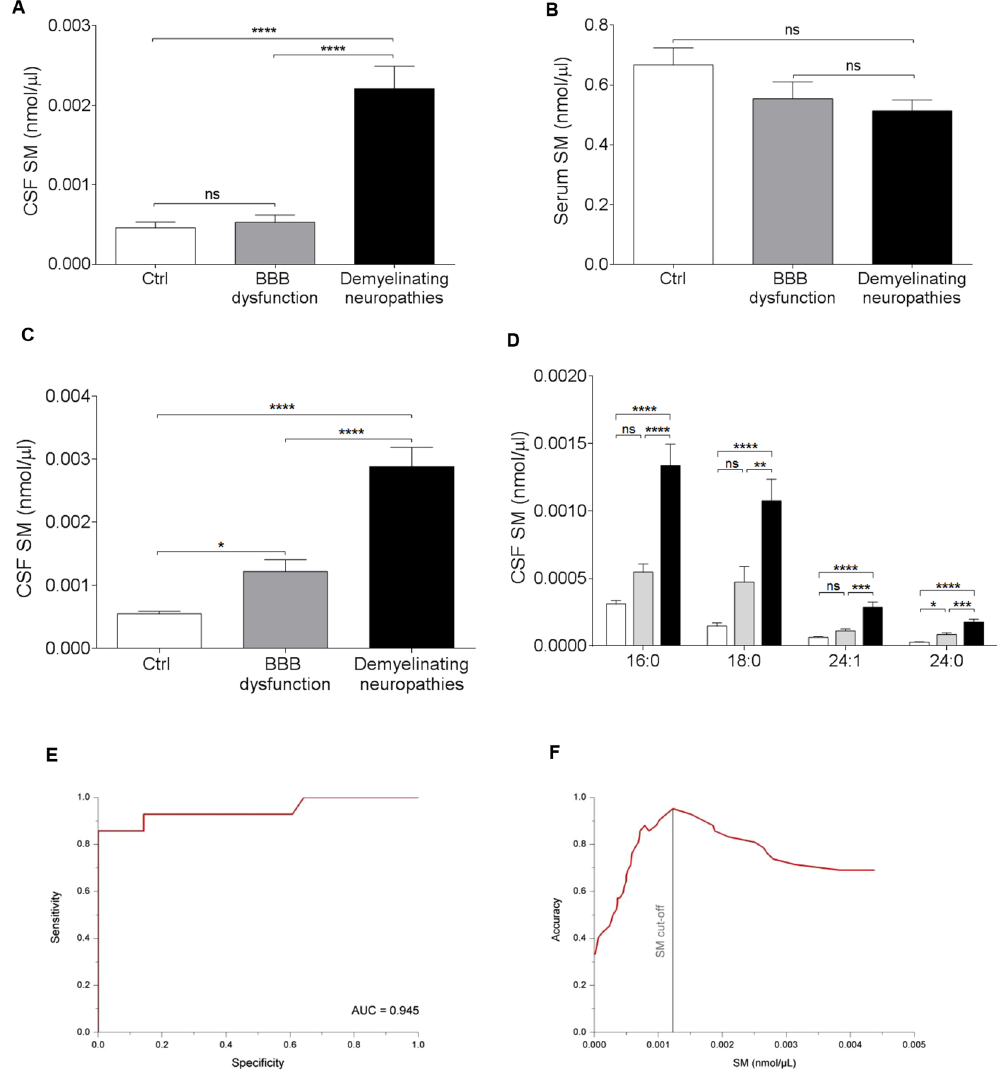
patients with demyelinating neuropathies compared to both the control groups. Interestingly, SM exclusively increased in the CSF of these patients to exclude a direct exchange with peripheral blood. ( C , D ) LC-MS/MS targeted-sphingomyelin analysis showed that the total SM species contribution is definitely consistent with those obtained by the fluorescence-based assay. 16:0, 18:0, 24:0, 24:1 are the most abundant SM species with different saturated and unsaturated fatty acid chains. ( E ) Specificity and sensitivity of SM assay were tested by ROC curve analysis ( F ) A cut-off value for SM was also calculated. *** p < 0.001, **** p < 0.0001, ns = not- significant. Holm-Sidak multiple comparison test after 1-way analysis of variance was used for statistical comparison in ( A – D ). ROC implementation in Mathworks MATLAB environment was used in E, F